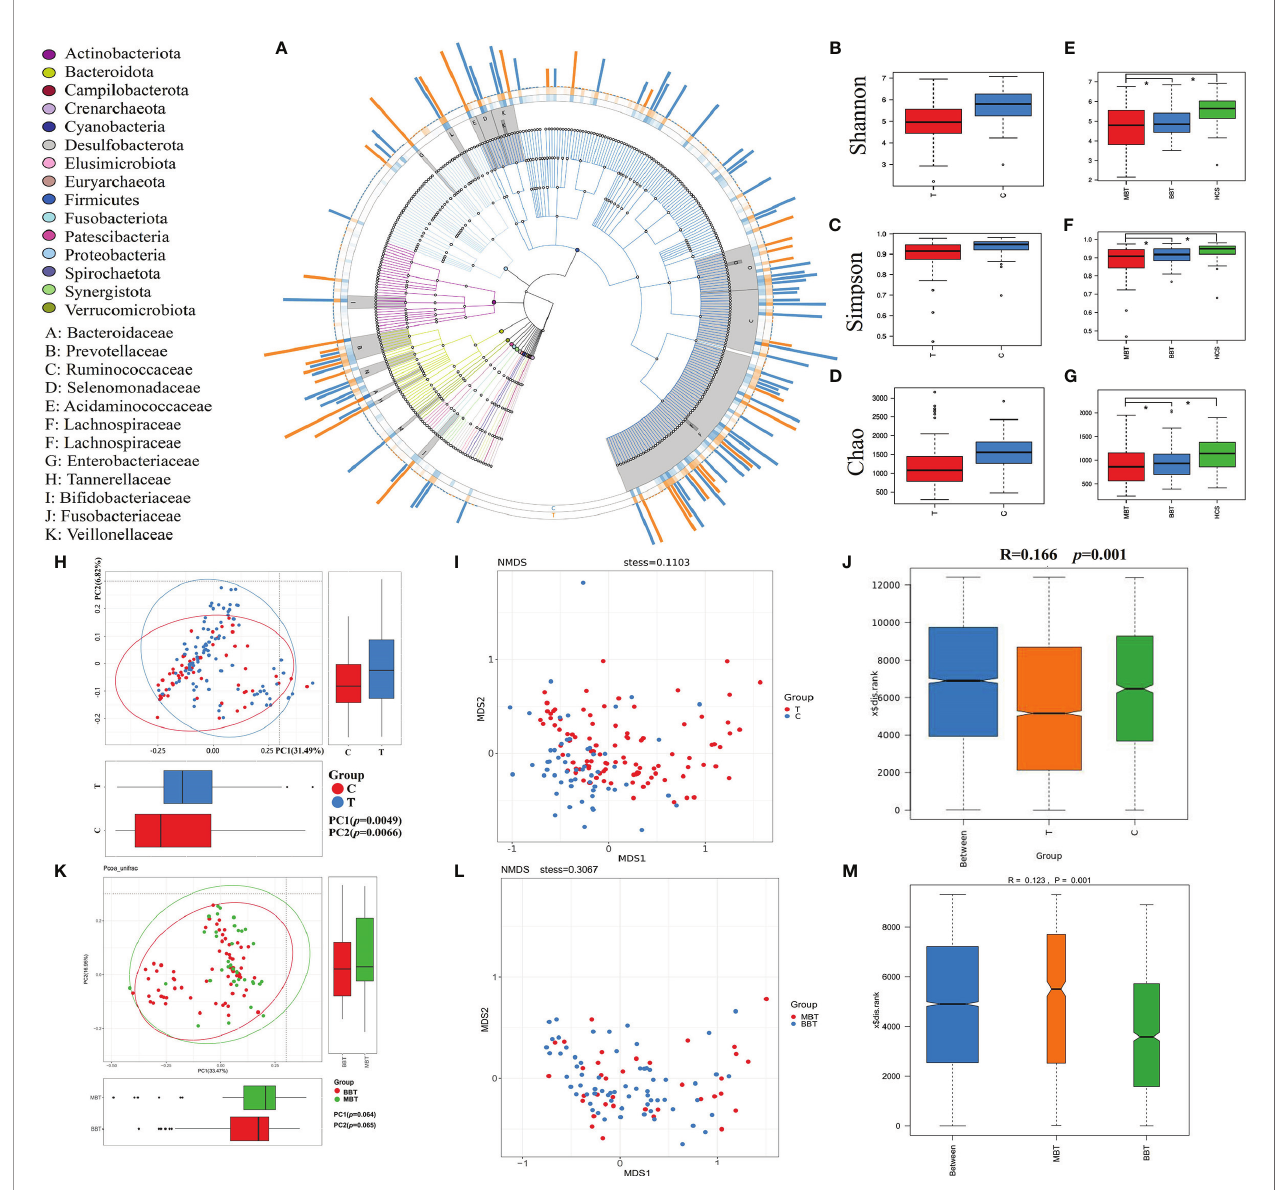
FIGURE 1 | The general distribution and microbial diversity in the gut microbiota of all participants. Distribution and species tree of the intestinal bacterial community (A) . The differences in alpha diversity were estimated by the Shannon, Simpson, and Chao1 indices. Shannon indices between the two groups (brain tumor group and healthy group, B ) and three groups (benign brain tumor group, malignant brain tumor group and healthy group, E ). The Simpson indices of the two groups (C) and three groups (F) . The Chao1 indices of the two groups (D) and three groups (G) . The variation in these data could be analyzed by unpaired t tests or Wilcoxon rank-sum tests. The asterisk suggests p < 0.05. Principal coordinate analysis (PCoA) based on the unweighted UniFrac distances and nonmetric multidimensional scaling of bacterial beta diversity between the brain tumor group and the healthy group (H, I) and between the MBT group and BBT group (K, L) . Each point represents a sample. Analysis of similarities (ANOSIM) between the brain tumor group and the healthy group (J) and between the MBT group and the BBT group (M) . We de fi ned p=0 when